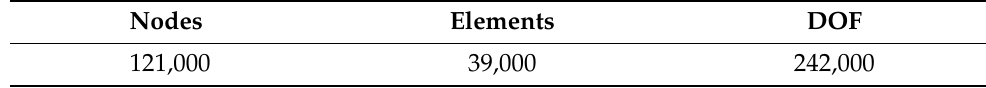
Table 7. Nonlinear computation model mesh statistics.